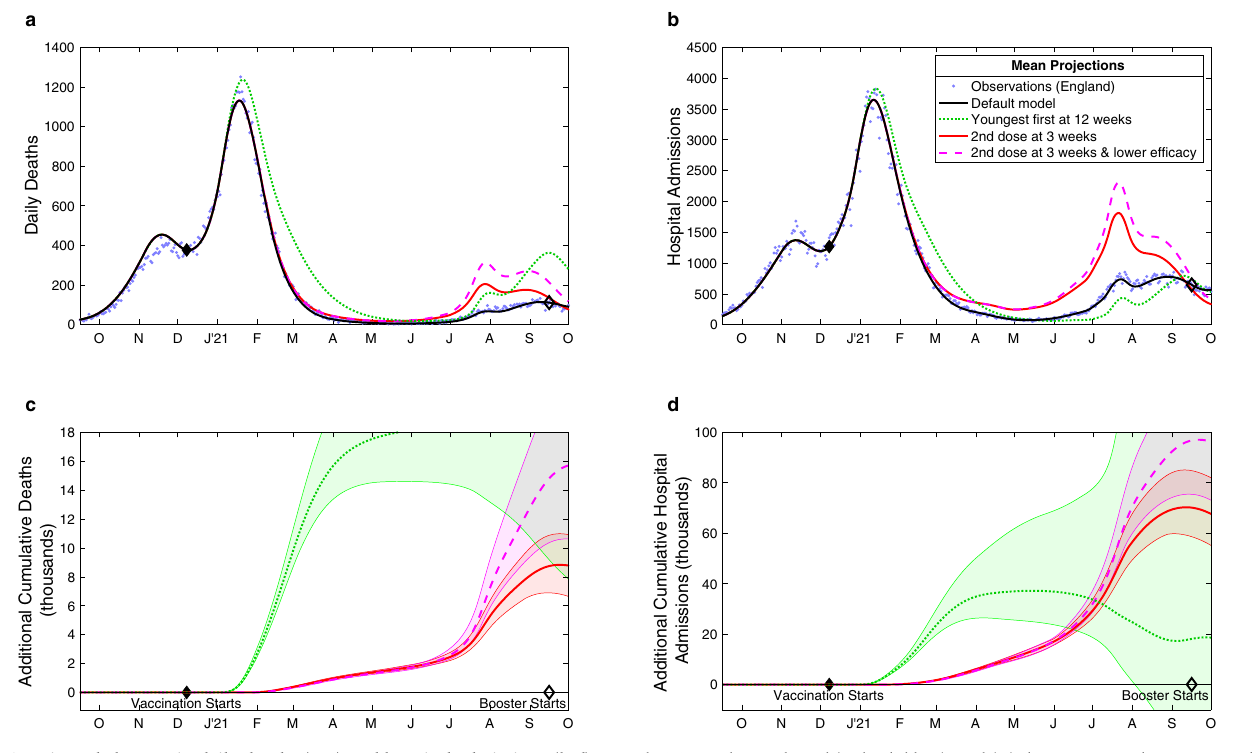
administered is unaltered (red solid line); and (iv) the same 3-week strategy as the red line, but accounting for lower ef fi cacy from the shorter dose interval (pink dashed line). c , d The cumulative additional deaths ( c ) and hospital admissions ( d ) projected from alternative assumptions, showing 95%prediction intervals (shaded regions)aswellasmeanvalues(lines).Allresultsarefrommodelsimulationsusing 400 samples from the parameter posterior